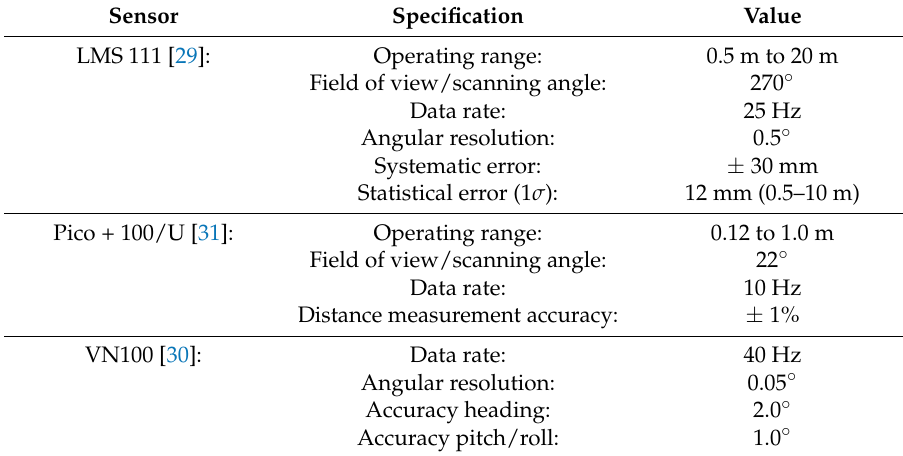
Table 1. Sensor specifications of the used sensors of the